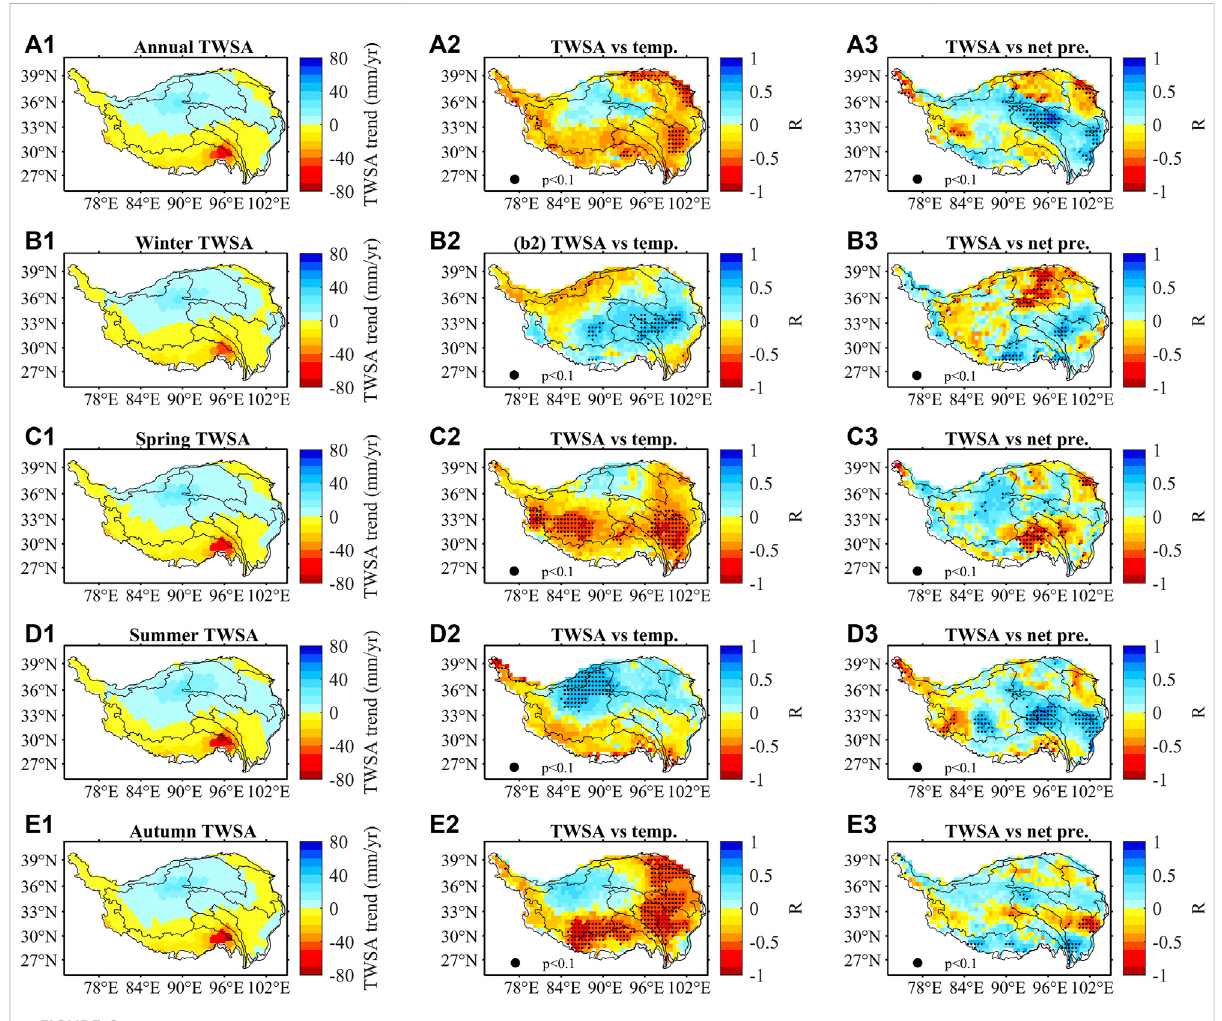
FIGURE 6 The spatial pattern of TWSA changes across the Tibetan Plateau from 2003 to 2016. From left to right: results for TWSA changes, the partial correlation between TWSA and temperature, and partial correlation between TWSA and net precipitation. From top to bottom: results for Annual, winter, spring, summer, and autumn. The black dots represent signi fi cance at the 0.1 con fi dence level ( p <